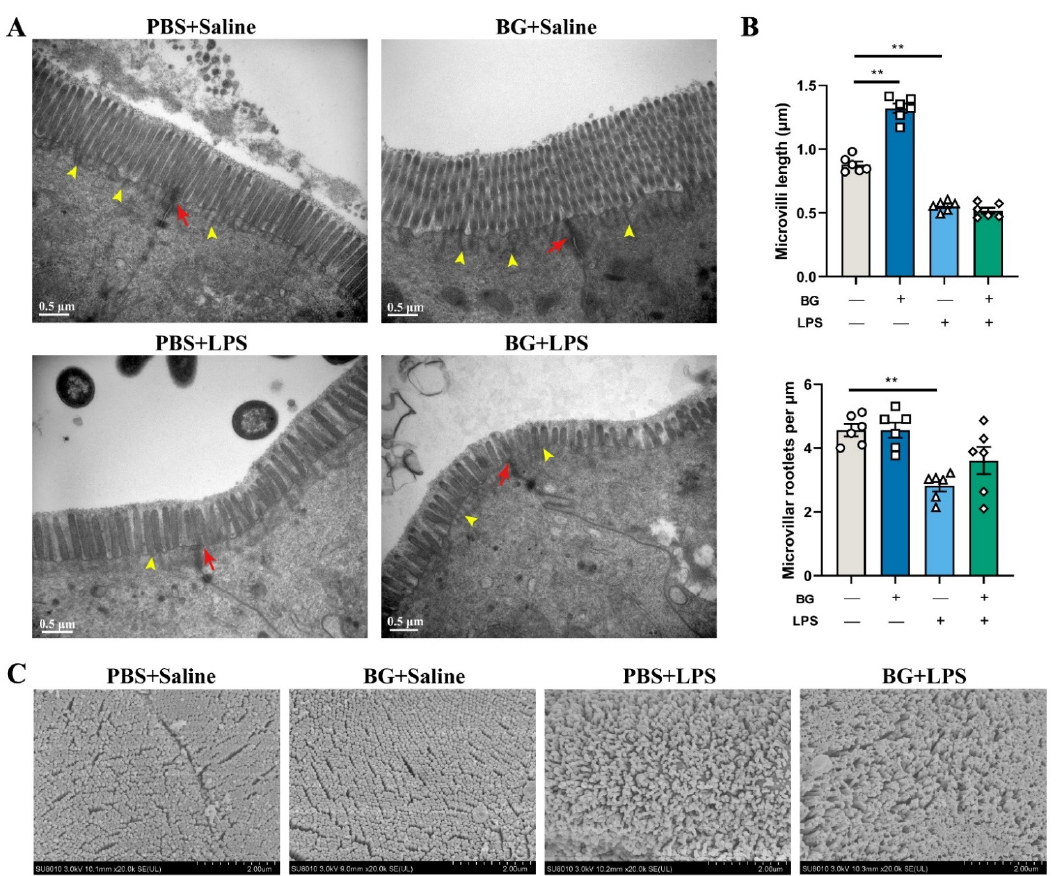
Figure 4. Attenuating effects of BG on the ultrastructure of jejunal epithelial cells in mice induced with LPS intraperitoneal injection. ( A ) Transmission electron microscope images of ileum epithelial cells (scale bar = 0.5 µ m); ( B ) jejunum epithelial cells microvilli length and average microvilli rootlet densities. “+” and “ − ” mean with and without corresponding treatments, respectively. ( C ) Jejunum epithelial cells scanning electron microscope images (20,000×). Yellow arrowheads designate rootlet ends, and red arrows designate tight junction structures. PBS+Saline, mice administered PBS and injected with saline; BG+Saline mice administered 1.5 g/kg BW BG and injected with saline; PBS+LPS, mice administered PBS and injected with LPS; BG+LPS, mice administered 1.5 g/kg BW BG and injected with LPS. Data are presented as mean ± SEM, n = 6. ** indicate significant difference ( p < 0.01). An unpaired t -test was used for statistical analysis between two groups.